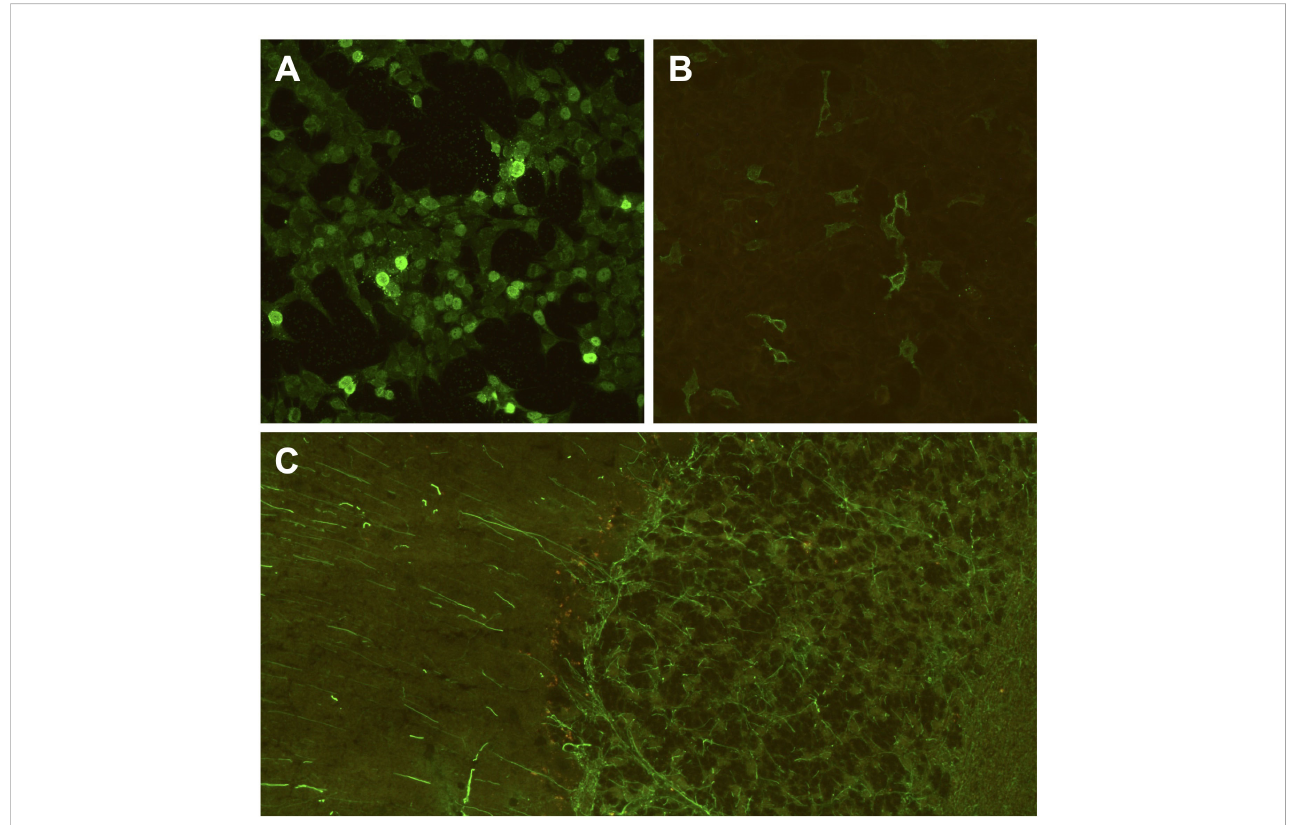
FIGURE 4 Brain-directed autoantibodies in ICI-treated cancer patients with irAE-n. (A, B) Cell-based assays of fi xed recombinant HEK293-cells (original magni fi cation x 200) expressing single neuronal antigens showing anti-Zic4 autoantibodies (1:100 dilution; A ) and anti-GABA B R autoantibodies (1:10, B ) in a patient with small cell lung cancer and Guillain-Barre ́ syndrome (GBS) after pembrolizumab treatment. However, anti-ganglioside autoantibodies, which are associated with GBS, were tested negative during clinical routine. (C) Tissue-based assay using indirect immuno fl uorescence screening on monkey cerebellum sections (original magni fi cation x 200) showing anti-GFAP autoantibodies (1:100 dilution) in a melanoma patient with encephalitis after treatment with ipilimumab and nivolumab. GABA B R, gamma-aminobutyric-acid B receptor; GFAP, glial fi brillary acidic protein; ICI, immune checkpoint inhibitor; irAE-n, neurological immune related adverse event; Zic4, zinc fi nger